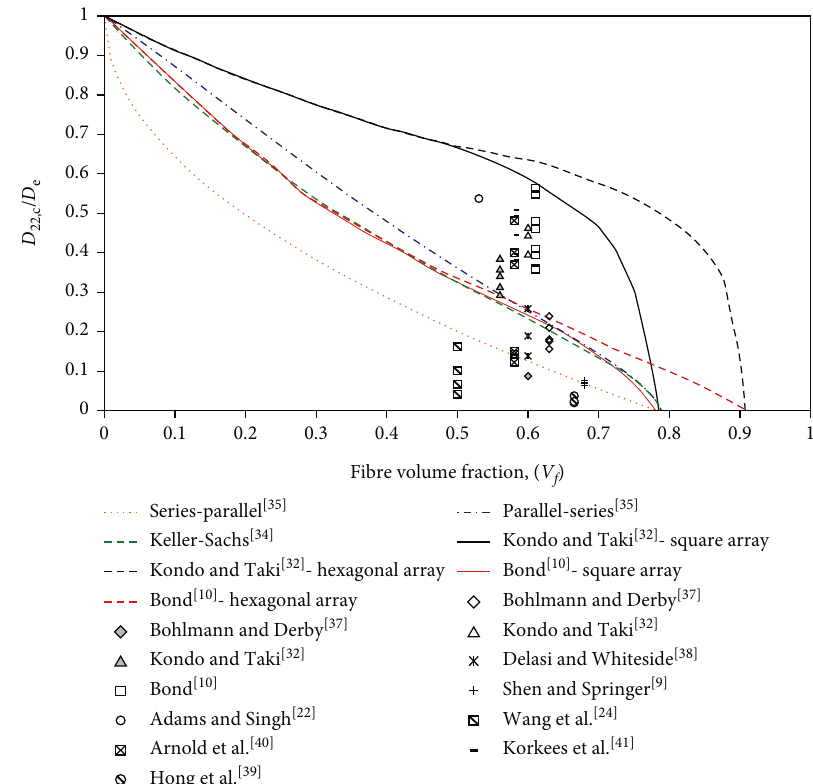
Figure 3: Comparison of experimental and modelled transverse di ff